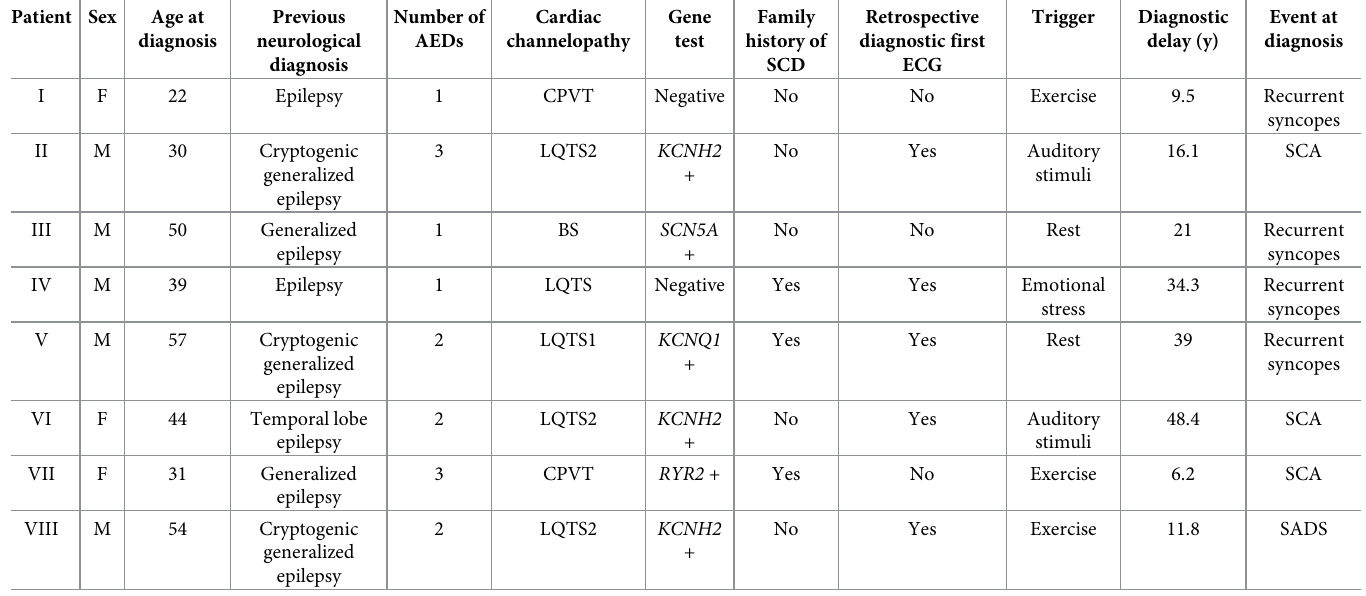
Table 2. Clinical features of patients with cardiac channelopathy and prior neurological diagnosis. AED: anti-epileptic drug; BS: Brugada syndrome; CPVT: catechol- aminergic polymorphic ventricular tachycardia; ECG: electrocardiogram; LQTS: long QT syndrome; SADS: sudden arrhythmic death syndrome; SCA: sudden cardiac arrest; SCD: sudden cardiac death; SQTS: short QT syndrome; F: female; M: male; y: